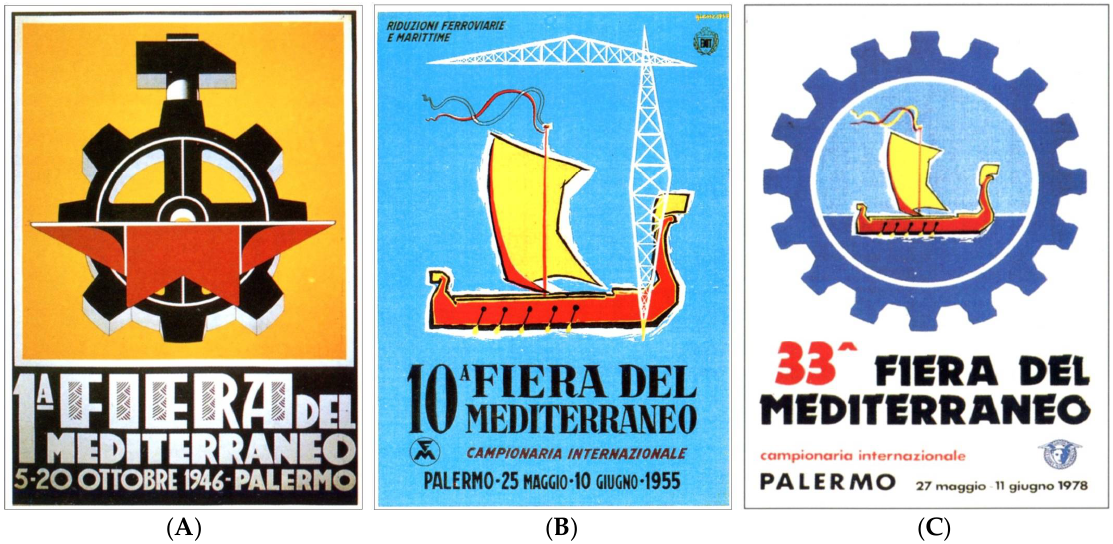
Figure 1. Some logos of the Fair: ( A ) first logo, 1946; ( B ) 10th edition, 1955; ( C ) 33th edition,